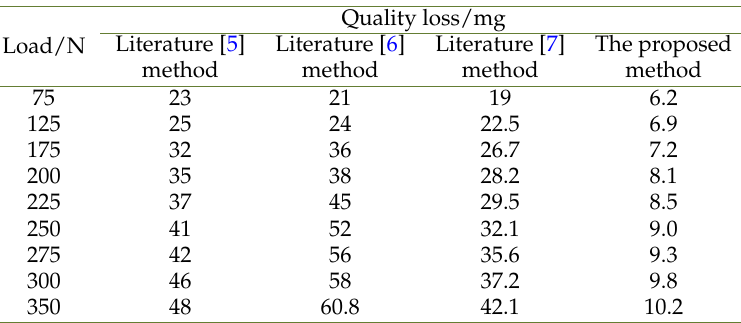
Table 2. Wear mass loss under different loads (use time 600